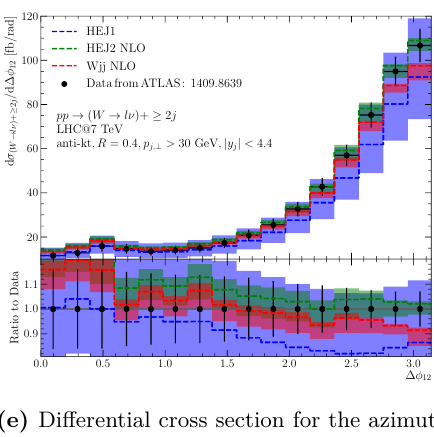
(c) Differential cross section for the transverse momentum of the leading jet.